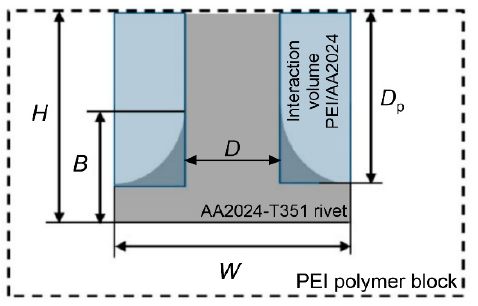
Figure 1. Schematic presentation of volumetric ratio according to Cipriano et al. [28,29].